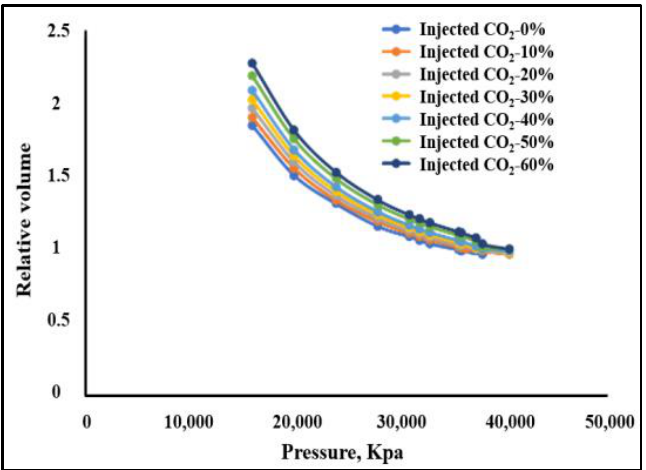
Figure 8. Relative volume versus pressure at different CO 2 injection molar quantity.